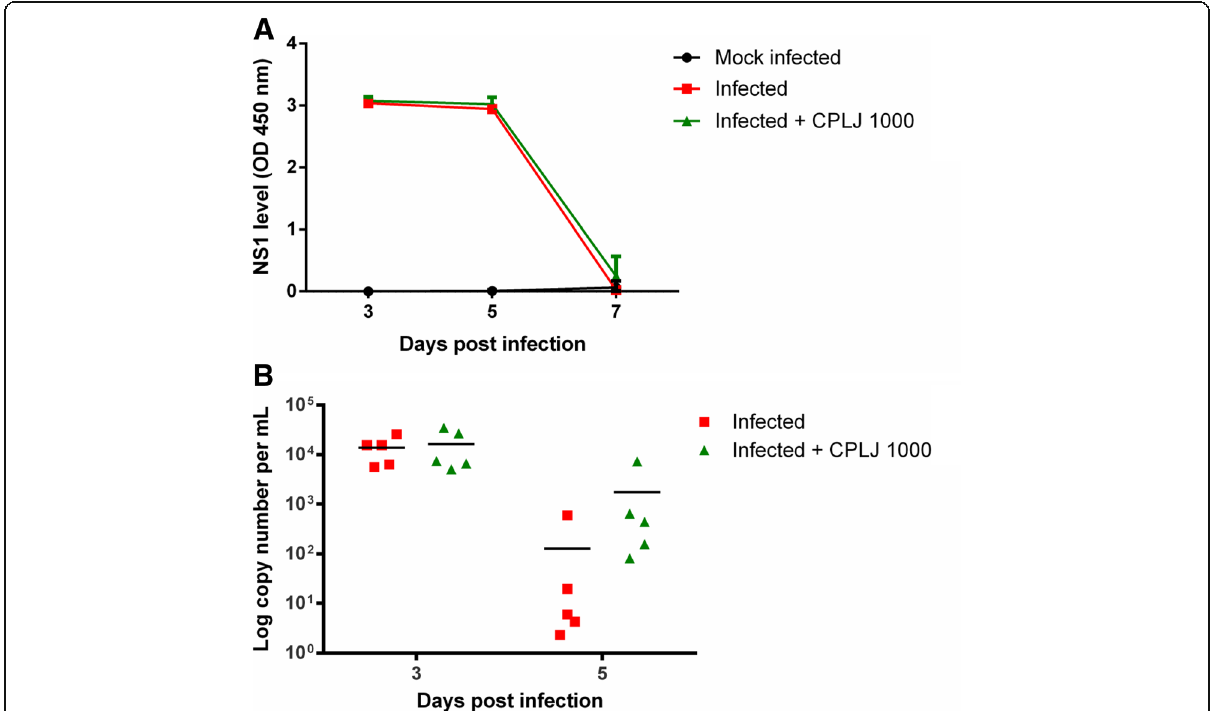
Fig. 5 An independent experiment showing that 1000 mg/kg BW freeze-dried C. papaya leaf juice was not affecting plasma NS1 and viral RNA levels in AG129 mice during dengue infection. ( a ) AG129 mice infected with dengue virus strain NGC (2 X 10 6 PFU) were treated with 1000 mg/ kg BW of freeze-dried CPLJ daily from day 1 to day 3 post infection. The plasma NS1 level of mock infected (black circles) ( n =5), infected (red squares) ( n =5) and infected+CPLJ 1000 (green triangles) ( n =5) AG129 mice groups were detected on day 3, 5 and 7 by NS1 antigen immunoassay. ( b ) The plasma viral RNA of infected (red squares) ( n =5) and infected+CPLJ 1000 (green triangles) ( n =5) AG129 mice groups were detected by quantitative reverse transcription PCR on day 3 and day 5 post infections. Data represent mean values ±